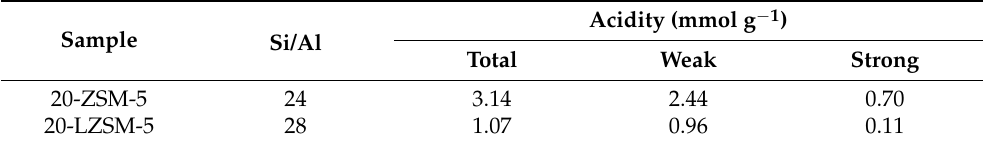
Table 2. Total, weak, and strong acidities determined through integration of the peak areas in NH 3 - TPD profiles for ZSM-5 and LZSM-5 synthesized at 20 h and their Si/Al ratio determined by EDX. Sample